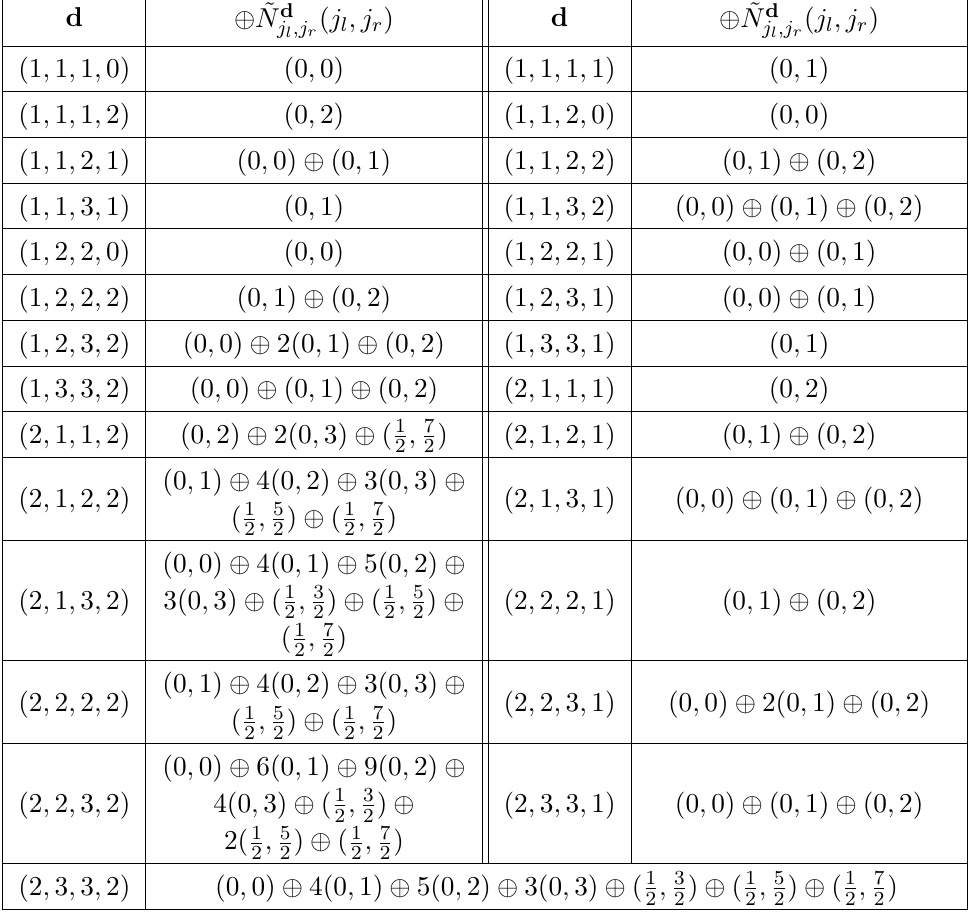
Spectrum of the anti-fundamental Wilson loop states in the SU(4) 6 theory for ( d 1 , d 2 , d 3 , d 4 ) ≤ (2 , 3 , 3 , 2) . Here, d = ( d 1 , d 2 , d 3 , d 4 ) labels the BPS states with fugacity Q Q d Q − 3 / 4 Q − 1 / 2 Q − 1 / 4 i 2 3 4 i